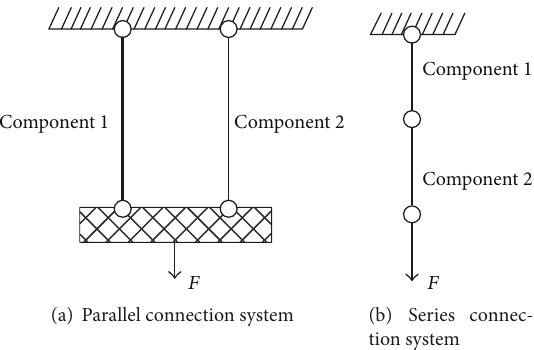
Figure 1: Illustration of importance coefficient in different